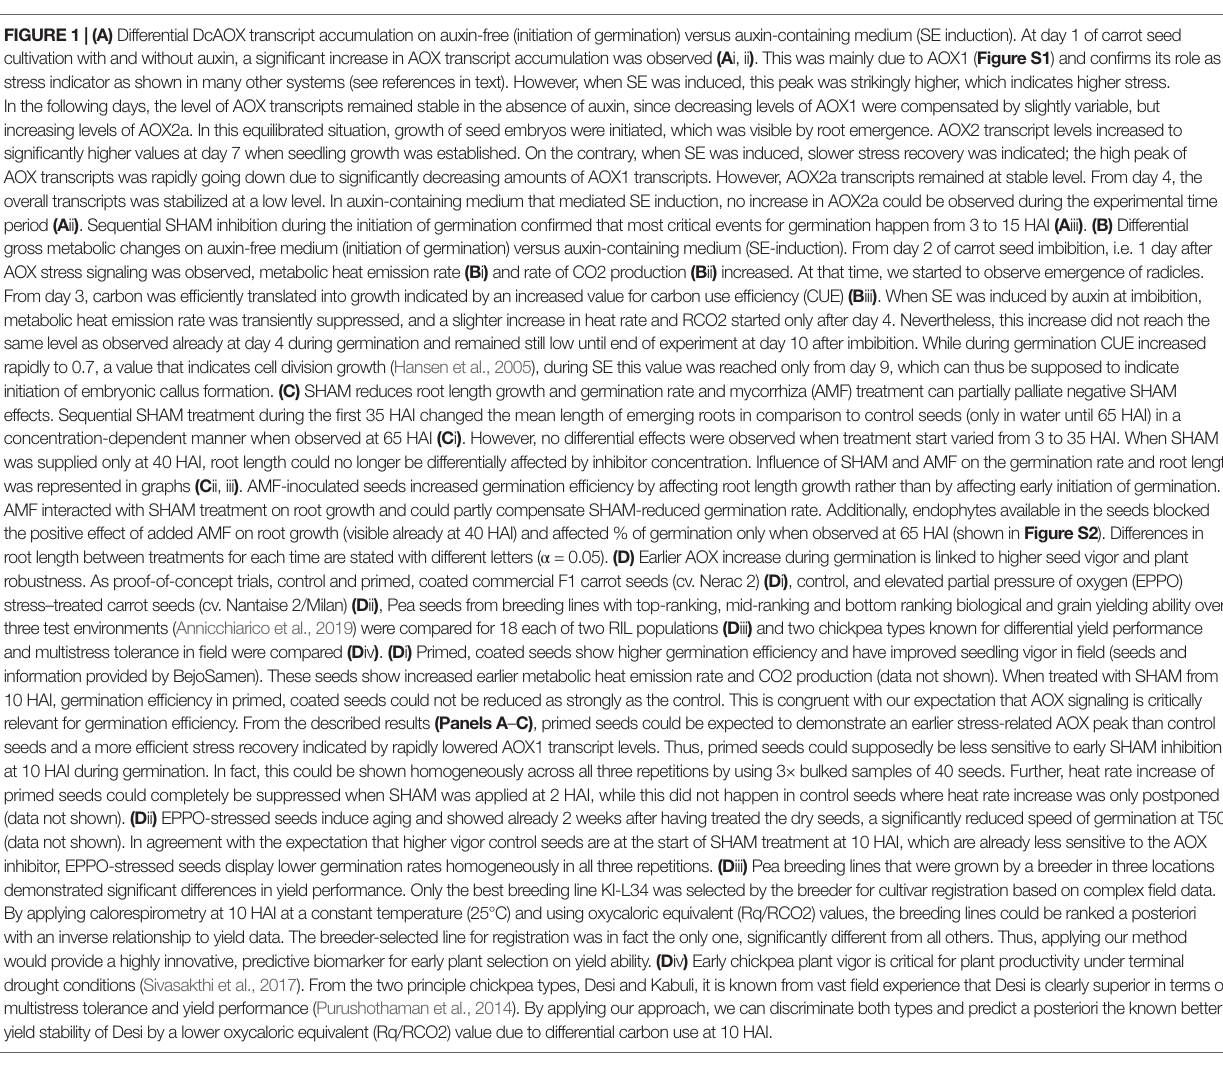
FIGURE 1 | (A) Differential DcAOX transcript accumulation on auxin-free (initiation of germination) versus auxin-containing medium (SE induction). At day 1 of carrot seed cultivation with and without auxin, a significant increase in AOX transcript accumulation was observed (A i, ii ) . This was mainly due to AOX1 ( Figure S1 ) and confirms its role as stress indicator as shown in many other systems (see references in text). However, when SE was induced, this peak was strikingly higher, which indicates higher stress. In the following days, the level of AOX transcripts remained stable in the absence of auxin, since decreasing levels of AOX1 were compensated by slightly variable, but increasing levels of AOX2a. In this equilibrated situation, growth of seed embryos were initiated, which was visible by root emergence. AOX2 transcript levels increased to significantly higher values at day 7 when seedling growth was established. On the contrary, when SE was induced, slower stress recovery was indicated; the high peak of AOX transcripts was rapidly going down due to significantly decreasing amounts of AOX1 transcripts. However, AOX2a transcripts remained at stable level. From day 4, the overall transcripts was stabilized at a low level. In auxin-containing medium that mediated SE induction, no increase in AOX2a could be observed during the experimental